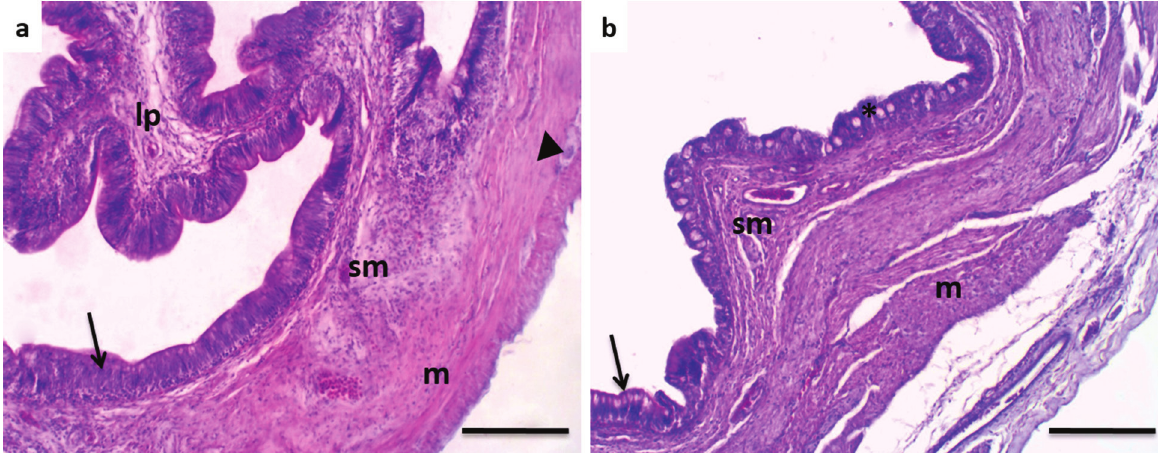
Figure 4 - Stratigraphy of intestinal tract of Sphoeroides testudineus . - a. Intestine showing mucosa with simple columnar epithelium (arrow) and myenteric plexus between the circular and longitudinal muscular layer (arrow-head). HE. - b. Rectum. Mucosa with simple columnar epithelium (arrow). Mucosa rich in globular unicellular mucous glands (*), lamina propria (lp), submucosa (sm), muscular layer (m). HE. Bar.: 100